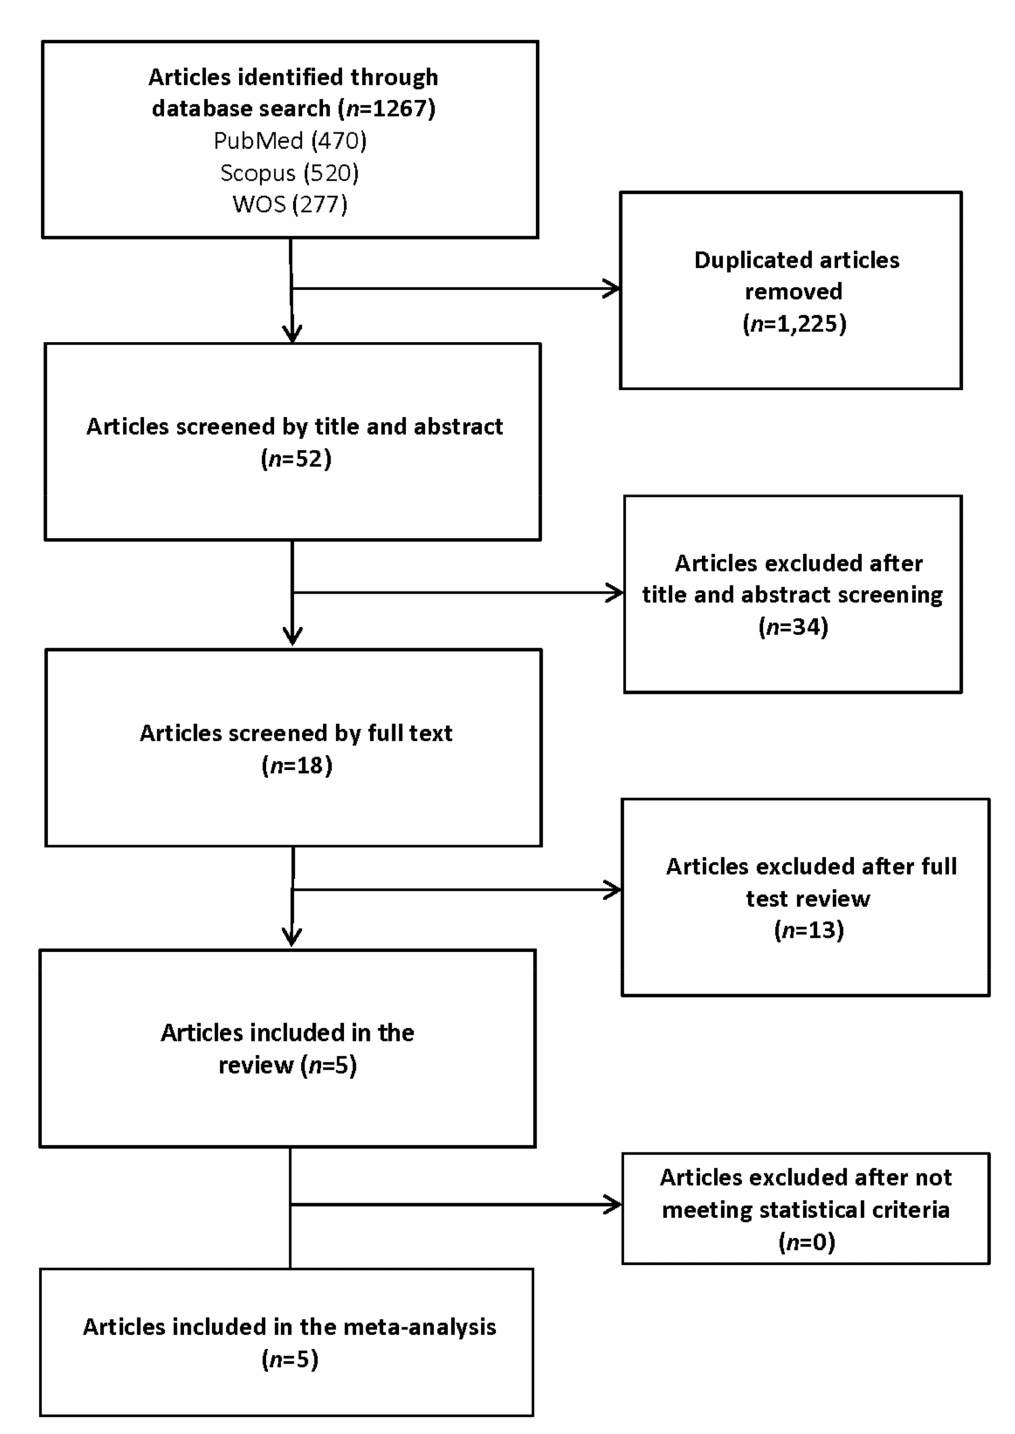
Figure 1. Search strategy to identify articles on the relationship between metabolic syndrome (MetS) and its components with severe acute respiratory syndrome (SARS) and/or mortality in patients with